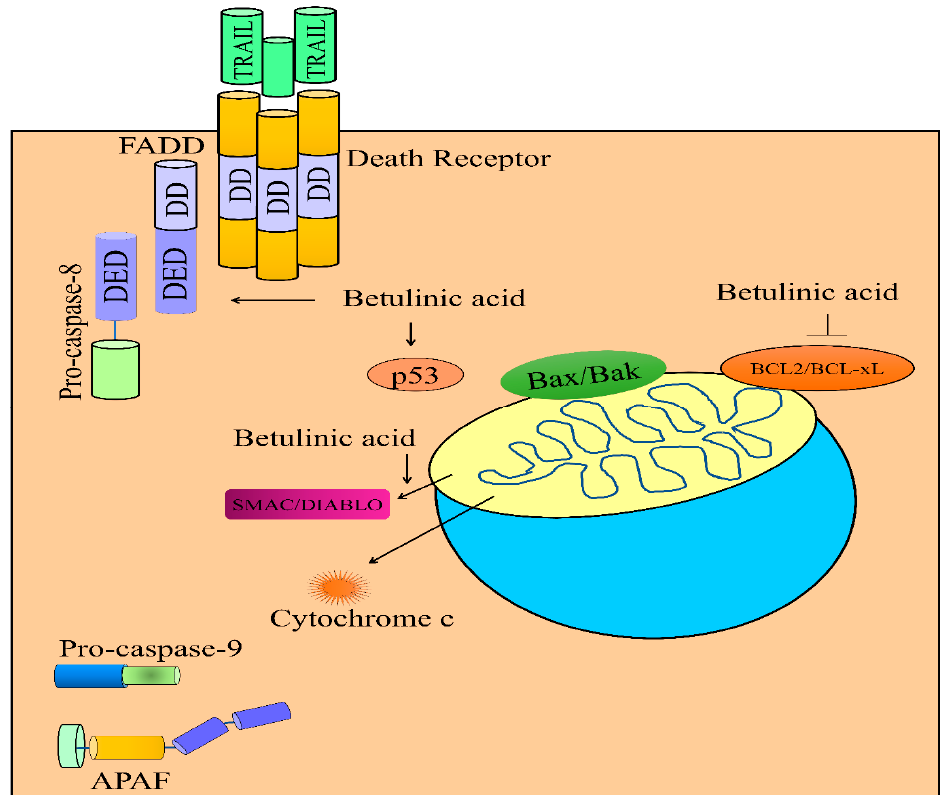
Figure 3. Regulation of TRAIL-mediated apoptosis by betulinic acid. Betulinic acid enhanced the levels of DR4/DR5 and FADD. Betulinic acid activated DISC (death inducible signaling complex). Betulinic acid triggered the release of cytochrome c and SMAC/DIABLO. Betulinic acid increased the levels of p53. Abbreviations: DR4/5 (Death receptor), FADD (Fas-associated death domain protein), DD (Death domain), DED (Death effector domain), APAF-1 (Apoptotic protease activating factor-1), Smac/DIABLO (Second mitochondria-derived activator of caspase/direct inhibitor of apoptosis-binding protein with low pI), MCL1 (Myeloid cell